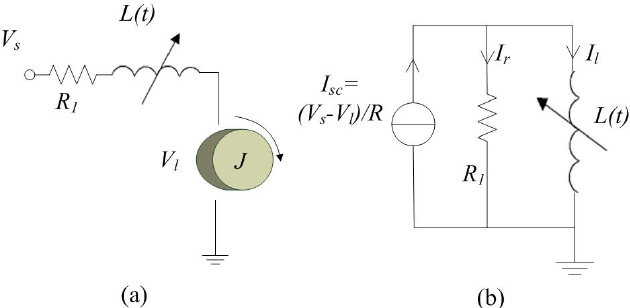
Figure 1. ( a ) Schematic diagram of a variable inductor in a DC motor and ( b ) its equivalent Norton